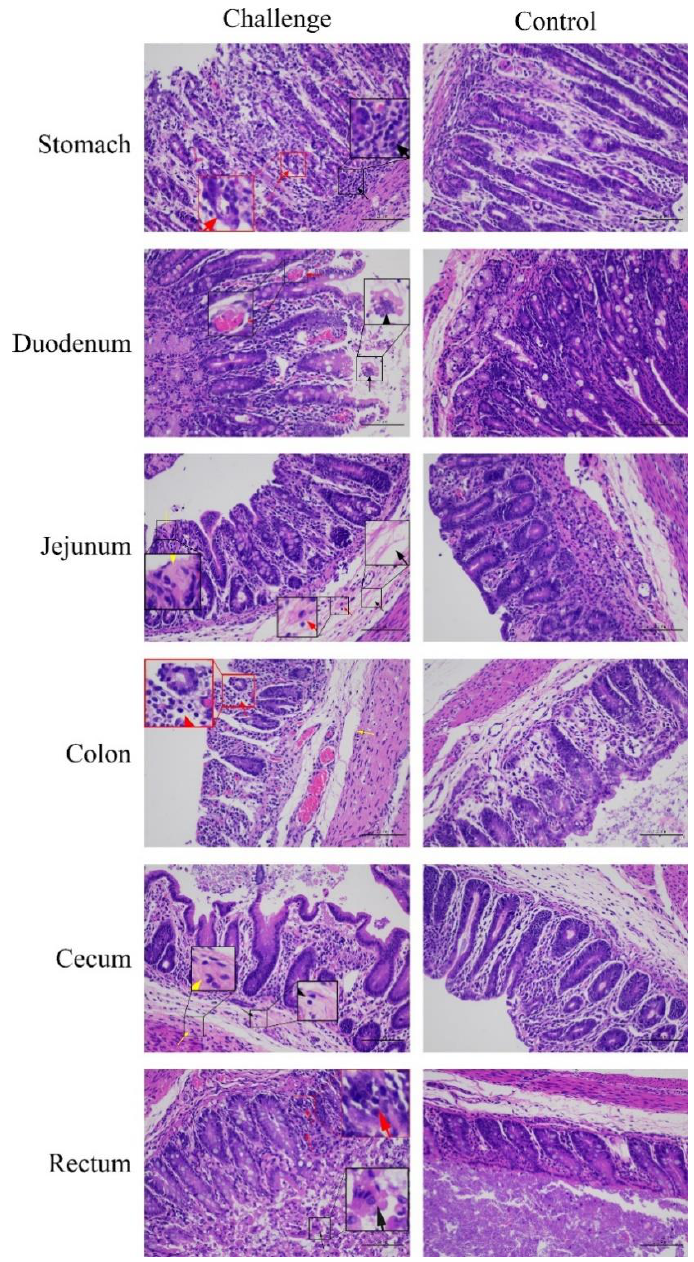
Figure 10. Histological analysis of gastrointestinal sections and stomach from piglets infected with PDCoV CHN-SC2015. The tissues from the piglets incubated with CHN-SC2015 or DMEM were collected at 5 DPI and were stained with hematoxylin and eosin. The different colors of arrows and boxes indicated the typical histological lesion in the different tissues. Scale bars are also shown in each picture.